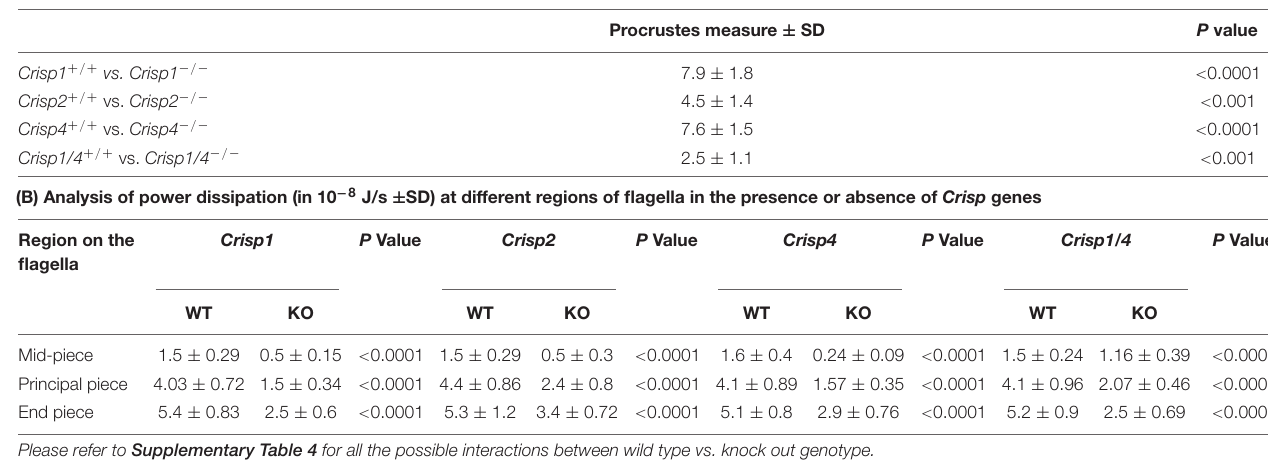
TABLE 1 | Comparative analysis of flagellar beating and kinematics across sperm from wild type and Crisp knock out mice. (A) The calculated Procrustes measure of flagellar beat across individual wild type mice lines. Wild type vs. Knock out